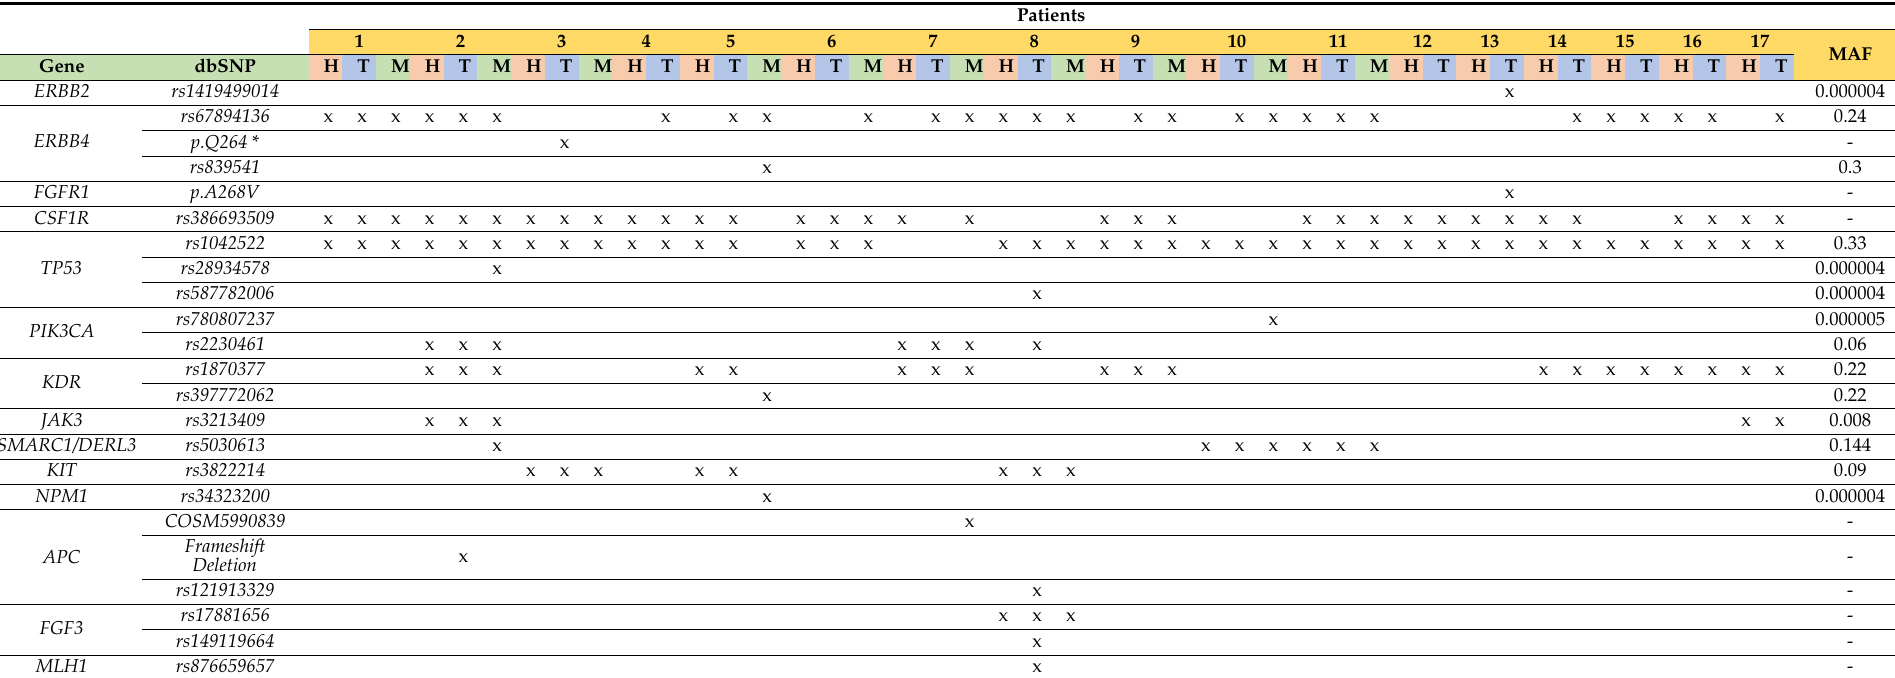
Table 2. Summary of sequenced mutations associated with a dbSNP code. At the top is the number of the patient with the respective samples (H = healthy tissue, T = primary tumor, M = metastatic lymph node). On the left are the mutations and genes on which they are placed. On the right, minor allele frequencies (MAF) are also